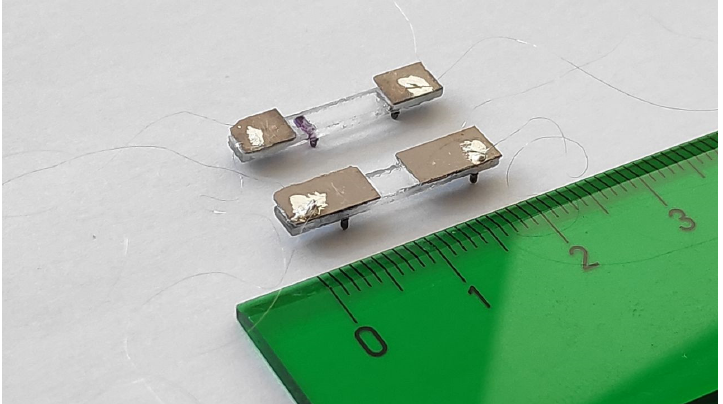
Figure 4. The view of a low-order combination structure, closer to the ruler, and a high-order combination structure. Ruler marked in centimeters.